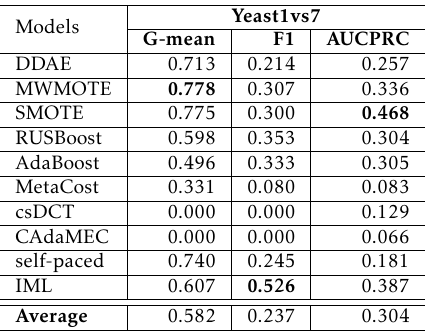
Table 15. Overall Results for Yeast1vs7 Dataset Models